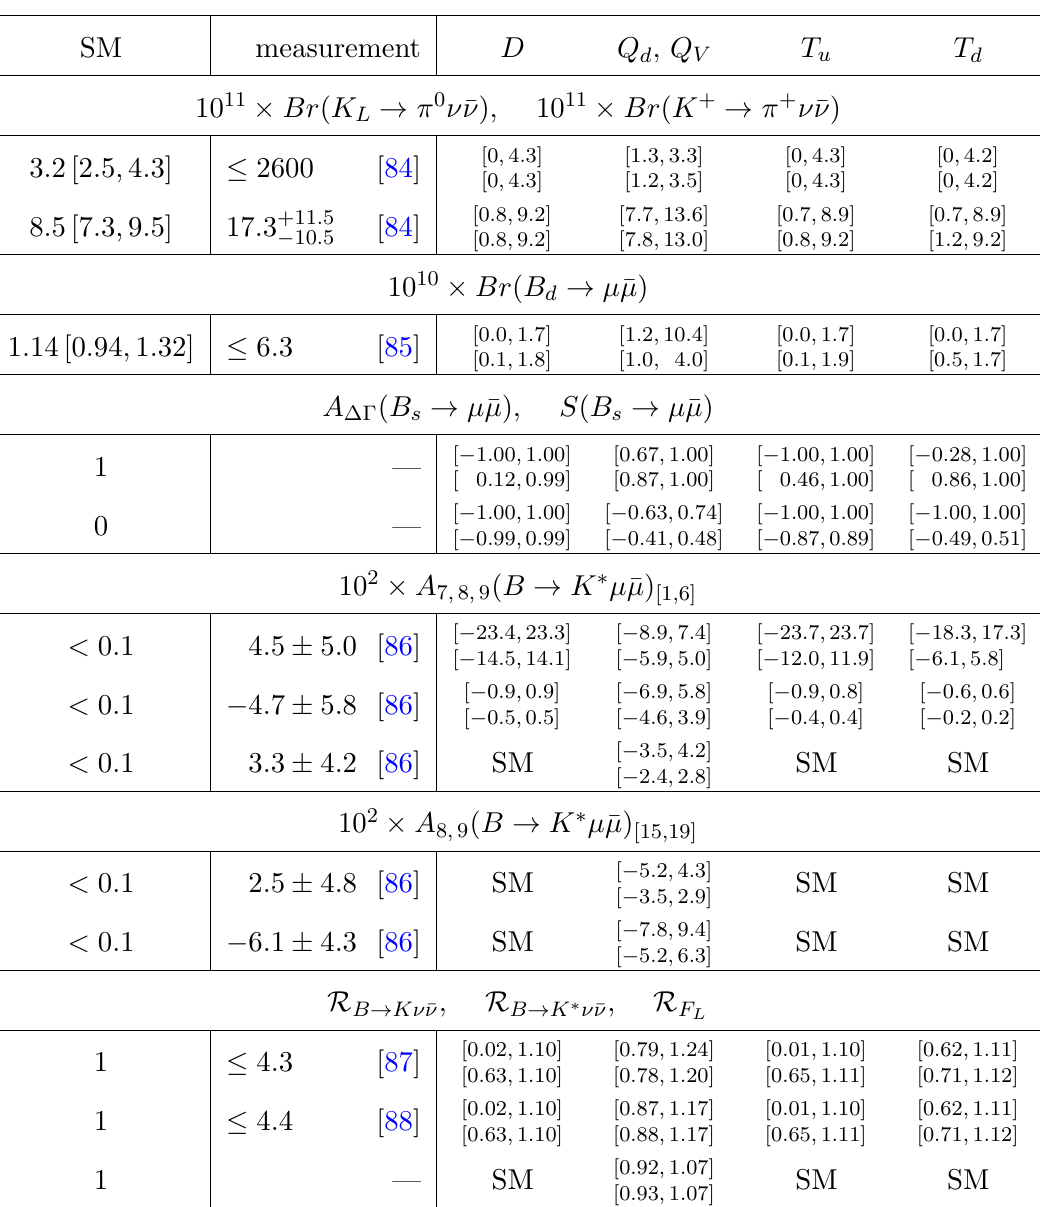
Table 9. Ranges still allowed for observables when taking the constraints from table 8 for the individual s d , b d and b s sectors into account, (cid:12)tting at the time same CKM and ! ! ! hadronic parameters. Upper and lower intervals are for M VLQ = 1 TeV and 10 TeV, respectively. Entries denoted as \SM" have tiny or no deviations from the SM. Experimental upper bounds are given at 90%